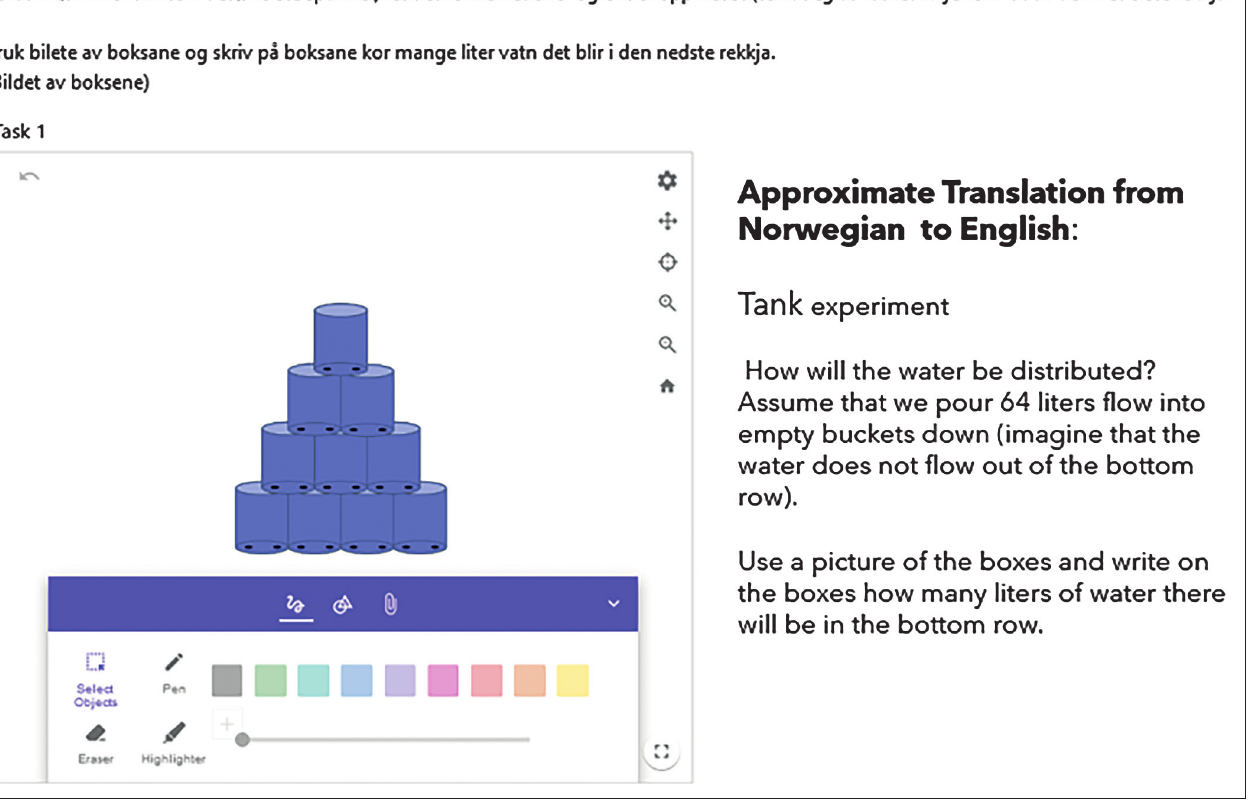
FIGURE 1: A task to reflect in connection to Pascal’s triangle during the virtual teaching on the digital platform Blackboard Collaborate using the Class function in